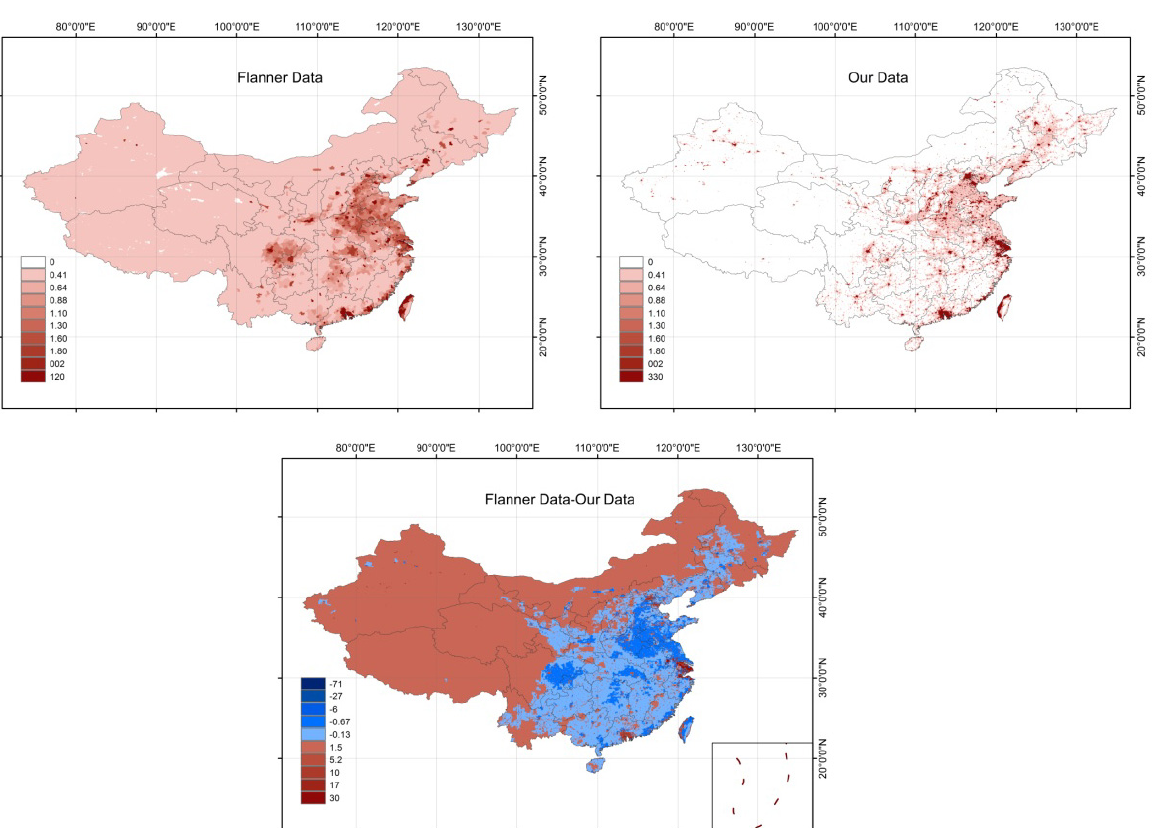
Figure 5. Flanner’s data of AHF, our data and spatial difference of AHF between Flanner and our data in 2005 (2.5 × 2.5